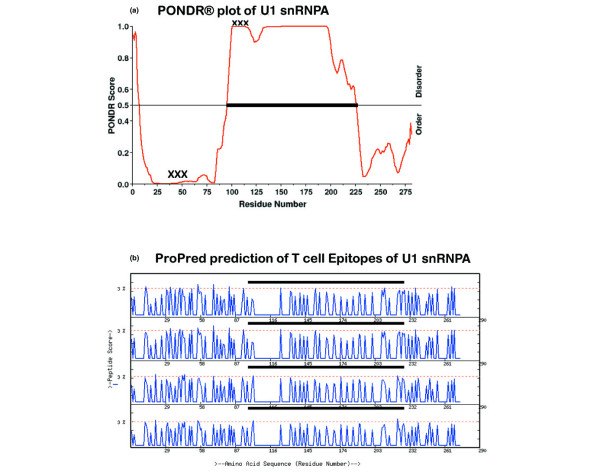
Disorder and T cell epitope for U1 snRNPA. (a) PONDR® plot of the U1 snRNPA protein (Swiss-Prot: P09012). The location of the strongly immunogenic peptide A3 (residues 44–56), which induces spreading and systemic autoimmune disease, is indicated by XXX. The weakly immunogenic peptide A6 (residues 103–115), which does not induce spreading or autoimmune disease [49], is indicated by xxx. (b) ProPred analysis of the U1 snRNPA protein in the context of MHC II. Only the results for alleles HLA-DRB_01, HLA-DRB_0102, HLA-DRB1_0301, and HLA-DRB_0305 are shown. The remaining 47 alleles show a very similar picture. The threshold is set at 3%. The black bar delimits the long disordered region of (a).